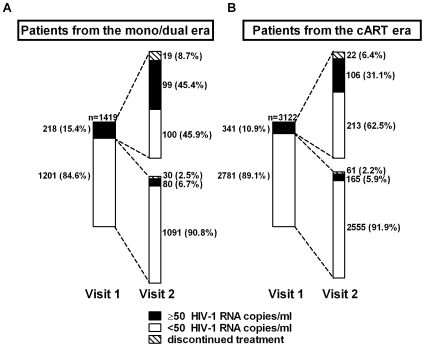
Virological course between the first follow-up visit in 2007 (visit 1) and the next semi-annual follow-up cohort visit (visit 2).Viral loads patterns are shown in the upper panels: (A) patients from the mono/dual ART era; (B) patients from the cART era.